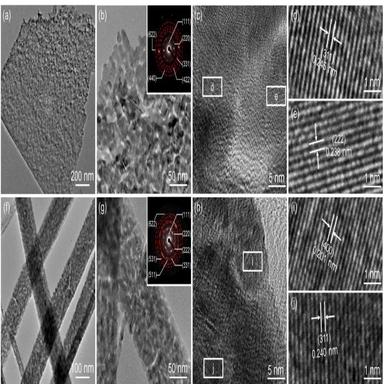
(a, b) TEM images and (c–e) HRTEM images of ZnCo2O4 NSs; (f, g) TEM images and (h–j) HRTEM images of ZnCo2O4 NWs. Insets of (b) and (g) show the SAED patterns of ZnCo2O4 NSs and ZnCo2O4 NWs, respectively.